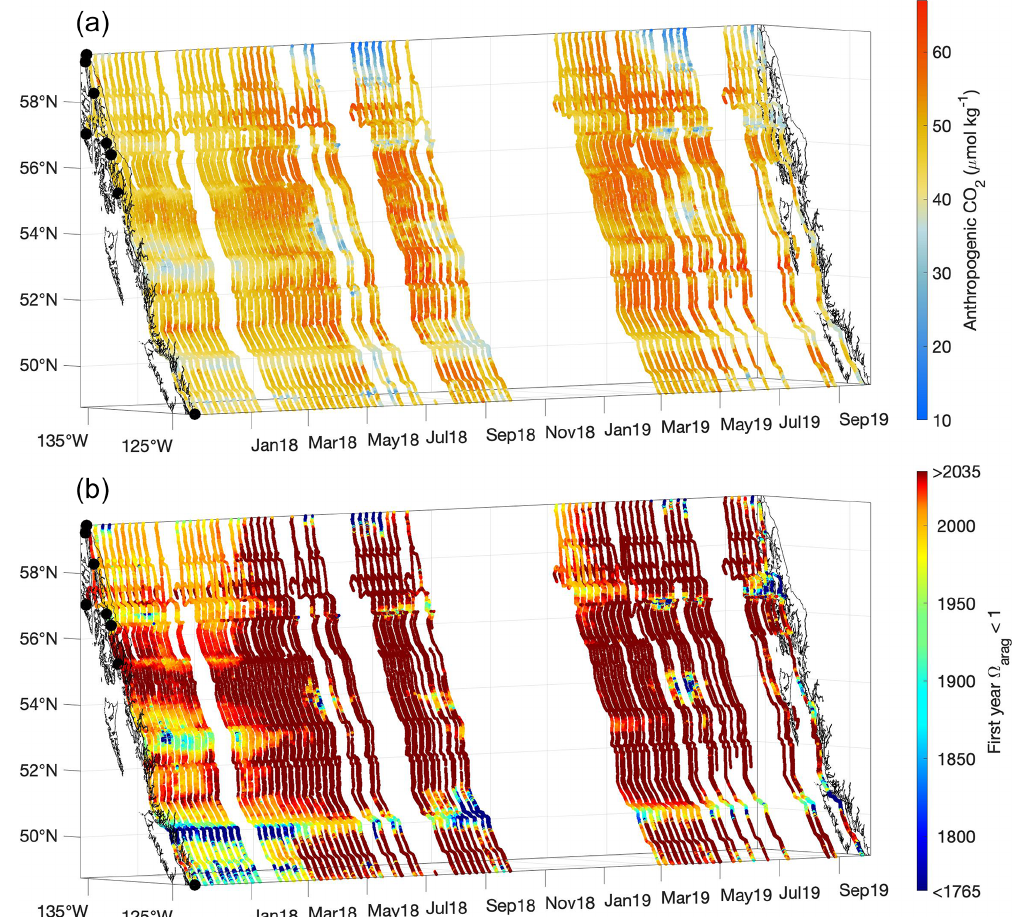
Figure 8. Contemporary anthropogenic CO 2 content (µmolkg − 1 ; a ) and the estimated first year when (cid:127) arag was < 1 ( b ). The x and y axes represent longitude and latitude, respectively, and with the coastline and terminal positions shown as in Fig. 1 and time increasing along the z